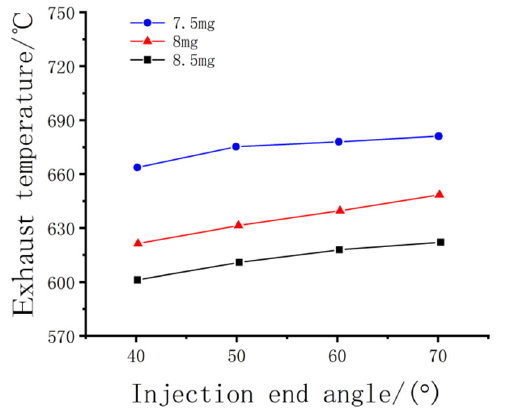
Figure 33. Effect of the injection parameters on exhaust temperature.